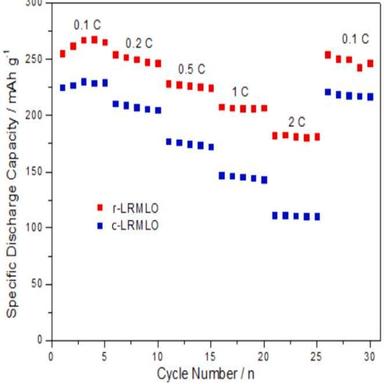
Comparision with rate capacities of r-LRMLO and c-LRMLO electrodes at different current rates of 0.1 C, 0.2 C, 0.5 C, 1 C and 2 C.